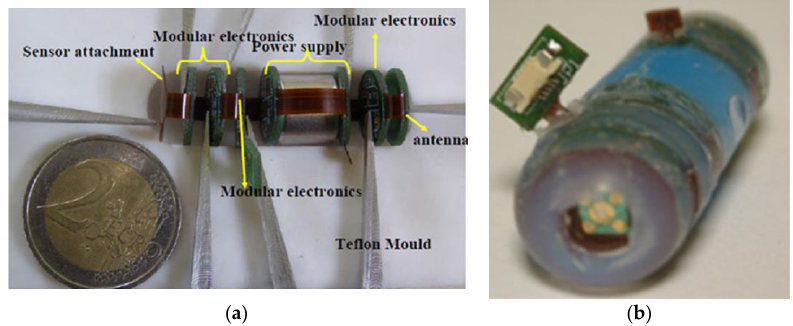
Figure 6. Sensor matrix in the form of a swallowable capsule. ( a ) prototype before packaging in the capsule, showing individual layers of the device; ( b ) final device packaged in polyether ether ketone; 12 mm × 28 mm (reprinted with permission from [139] © Elsevier).